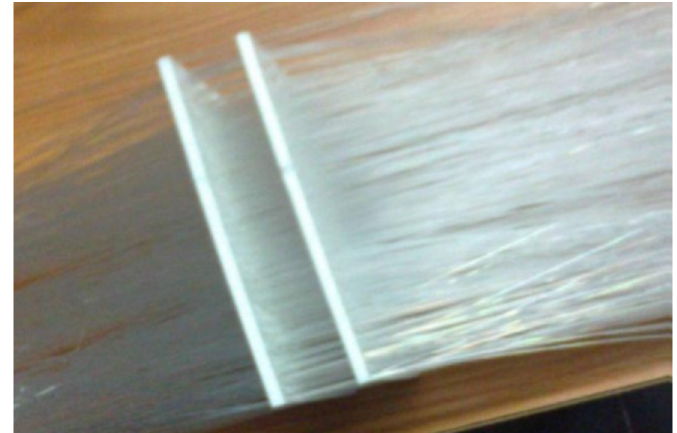
Figure 2. Optical fibres arrangement [54].